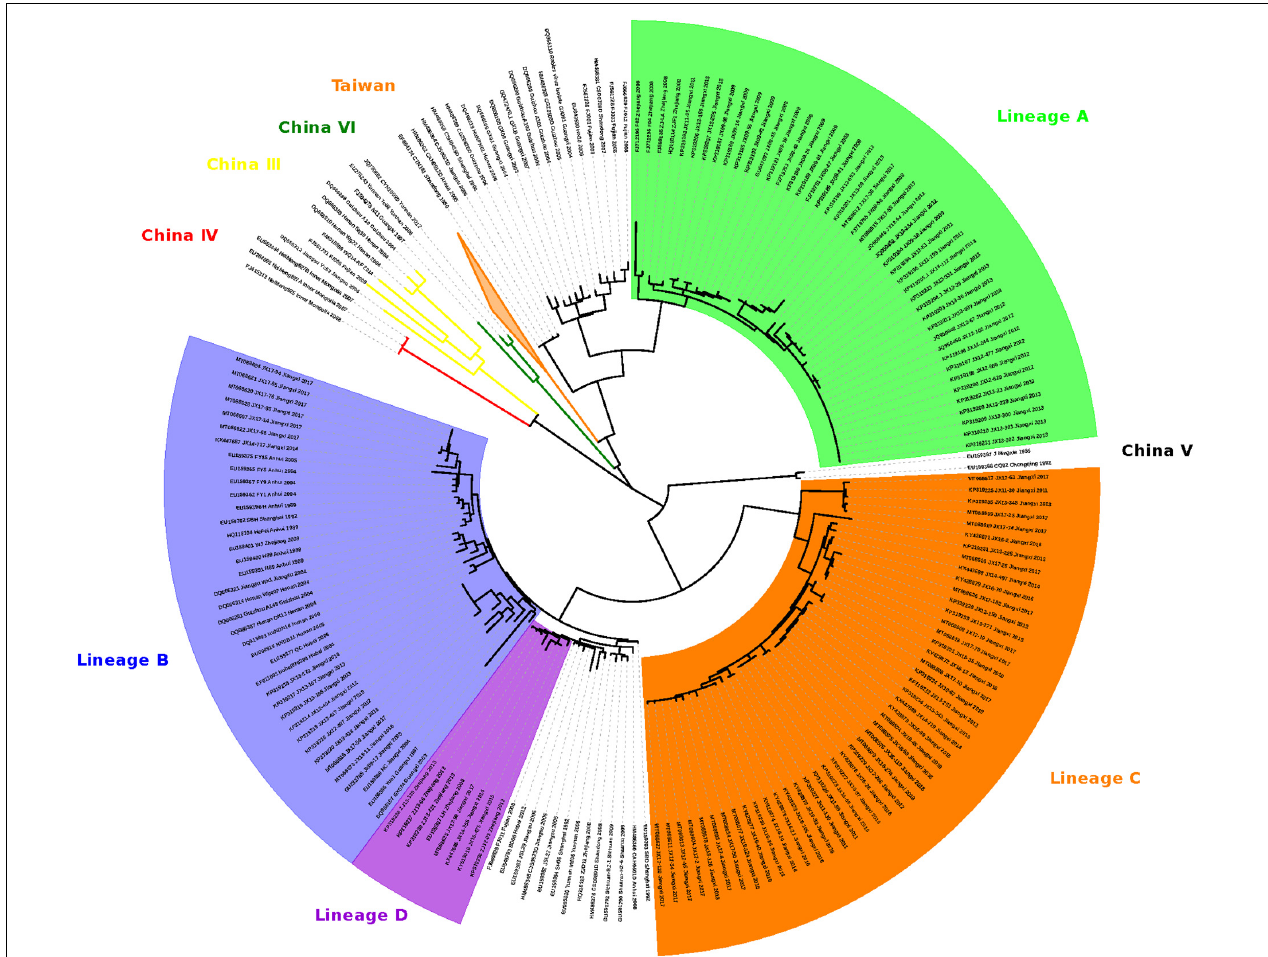
FIGURE 2 | Maximum likelihood phylogeny of 244 RABV sequences separates the 112 FB-associated RABVs into 4 distinct Lineages: A, B, C, and D. Lineage A was rooted with China dog RABV Group II, Lineages B and D with China dog RABV Group I, and Lineage C was independent, sitting in the middle of Group I and II. The numbers below the branches were bootstrap values (%) of 1,000